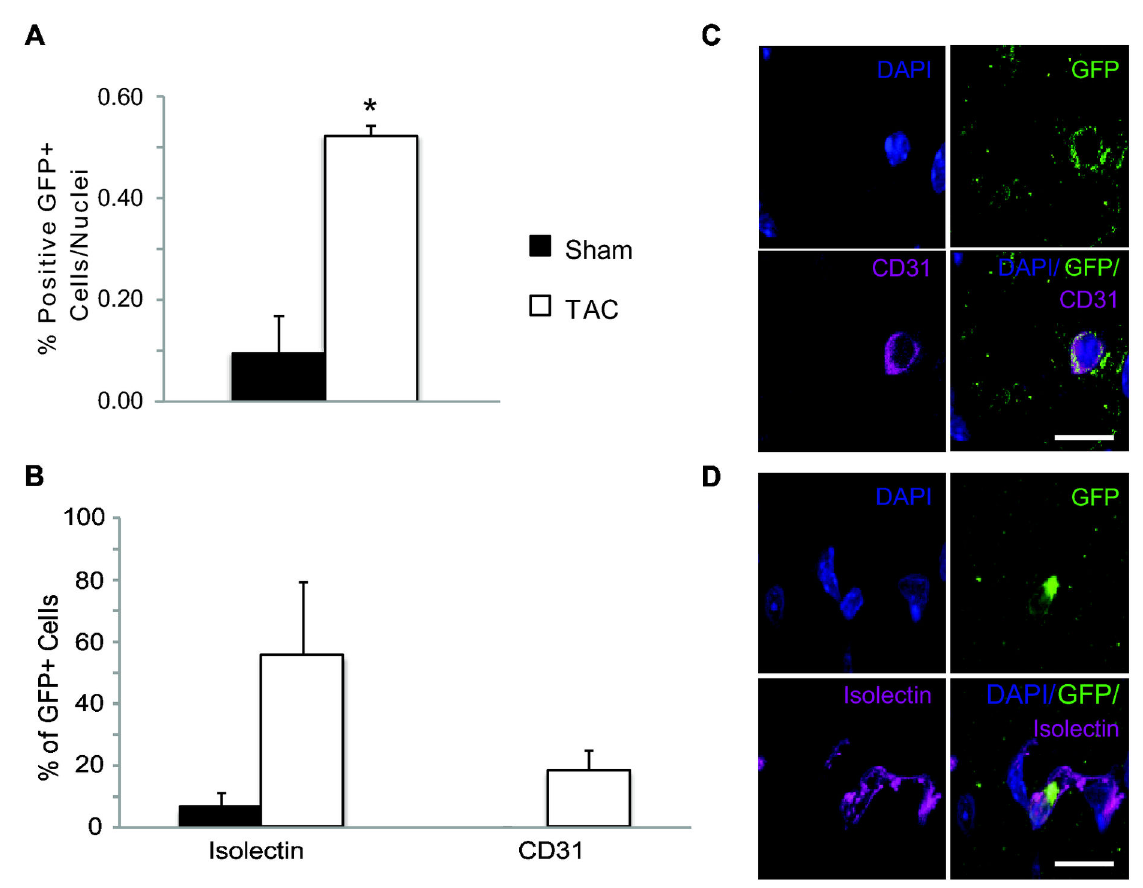
Figure 5. Bone Marrow Recruitment to the Heart is Reduced when SSEA1 Cells are Depleted from the Bone Marrow. (A) Bar graph representing the number of bone marrow cells (GFP+) in the myocardium in sham (black bars) and TAC (white bars) animals. In sham animals, there are significantly fewer bone marrow cells in the heart of SSEA1-BM mice compared to animals with total BM. Four weeks after TAC, GFP+ cells were significantly increased in the myocardium in mice with total BM but not in SSEA1- BM mice. (B) Quantification of the percentage of total vessels that are GFP+ (bone marrow derived) in sham and TAC animals. The percentage significantly increased after TAC in mice with total BM compared to sham. No differences were measured between sham and TAC SSEA1-BM mice or between sham groups. (C) Representative immunoflourescence images of bone marrow recruitment and bone marrow participation in angiogenesis in the myocardium (40x). Bone marrow cells are identified as GFP+ (red), vessels as Isolectin B4 + (green), and nuclei are labeled by DAPI (blue). n = 4-6. # P = 0.006 between sham animals. * P < 0.05 compared to respective sham. Abbreviations: SSEA1, stage-specific embryonic antigen 1; GFP, green fluorescent protein; TAC, trans-aortic constriction; SSEA1-BM, SSEA1+ cell depleted bone marrow; BM, bone